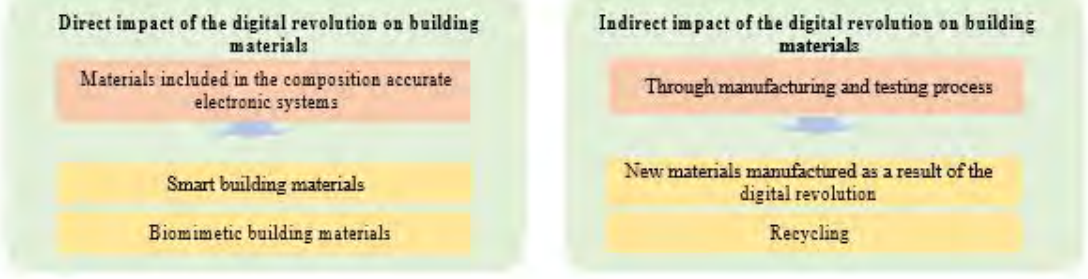
Figure 6. The impact of digitalrevolution on